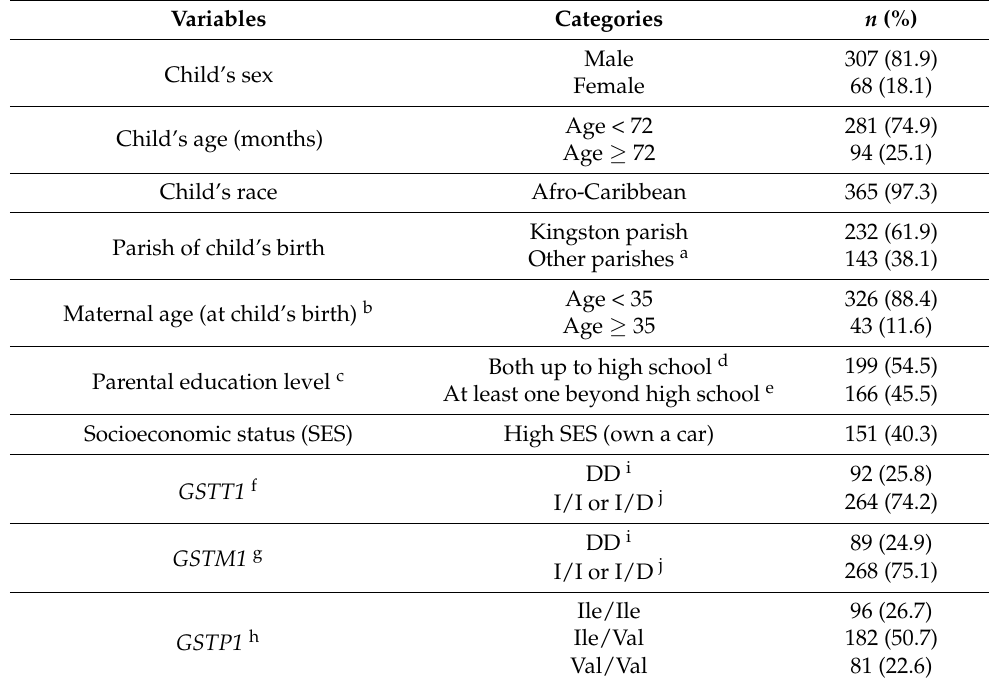
Table 1. Demographic and socioeconomic characteristics of children and their parents ( n =